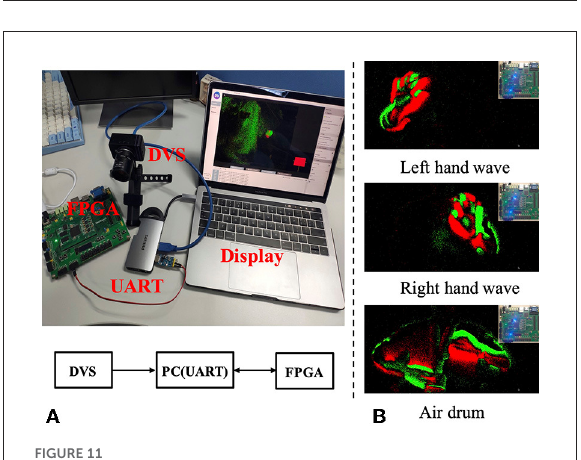
FIGURE11 (A,B) The experimental setup: an SGF inference model is implemented on an FPGA ZedBoard XC7Z020-CLG484-1 for testing system hardware